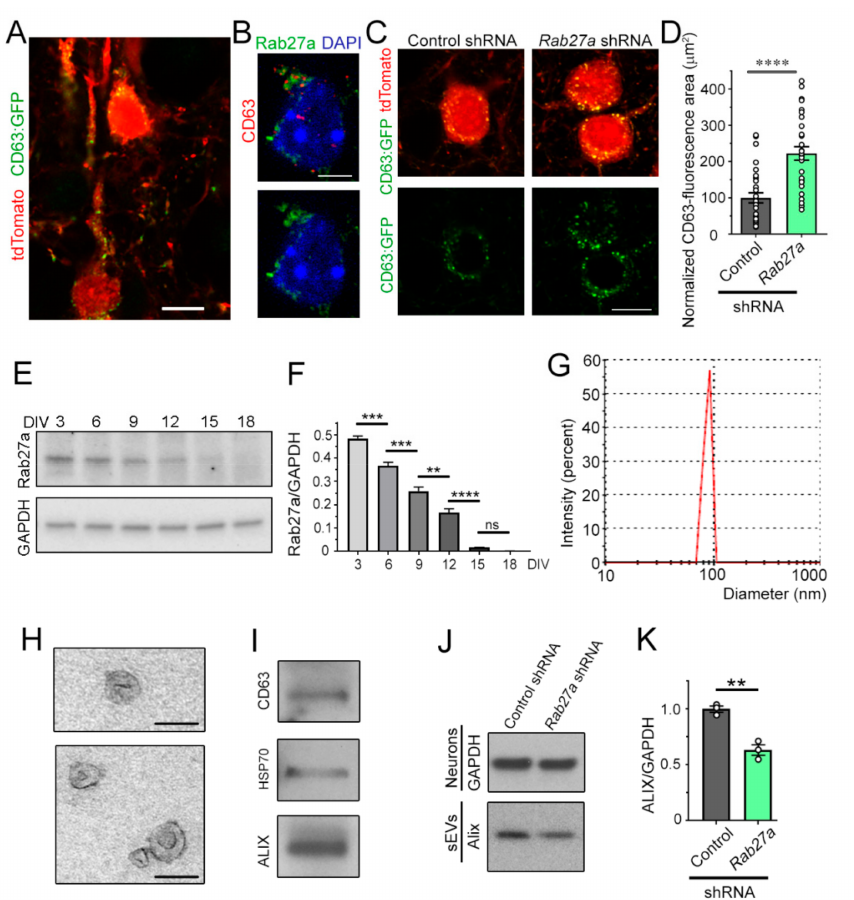
Figure 4. Rab27a regulates the release of small extracellular vesicles (sEVs) from developing cortical neurons. ( A ) Image of CD63:GFP and tdTomato fluorescence in late-born pyramidal neurons at P7 following IUE at E15. ( B ) Co-immunostaining for CD63 (red) and Rab27a (green) in a pyramidal neuron (P7 coronal section). ( C ) tdTomato and CD63:GFP fluorescence in pyramidal neurons from P7 mice that received CD63:GFP and either empty vector (control) or Rab27a shRNA following IUE at E15.5. ( D ) Plot of the normalized area occupied by CD63 immunostaining. ( E , F ) Immunoblots for Rab27a and GAPDH ( E ) from primary cortical neurons at different DIV and quantification of the blots ( F ). ( G ) Histogram of size distribution of sEVs determined by Nanoparticle Tracking Analysis. ( H ) Electron micrographs of purified sEVs. ( I ) Immunoblots for markers of sEVs. ( J , K ) Immunoblots of Alix from sEVs and GAPDH from neurons containing control (empty) shRNA vector or Rab27a shRNA ( J ), and quantification of the blots ( K ). These data were from the same cell cultures performed for Figure 1B. Plots are mean ± SEM. **: p < 0.01, ***: p < 0.001, ****: p < 0.0001, and ns: not significant, Student’s t-test. Scale bars: 15 µ m ( A , C ), 7 µ m ( B ), and 125 µ m ( H